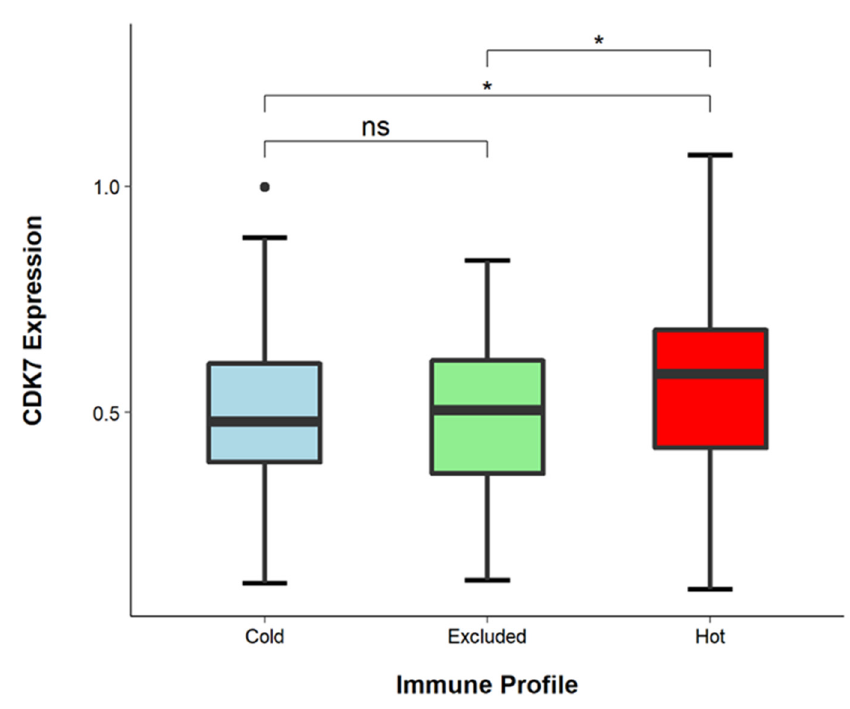
Figure 4. CDK7 expression in different tumor immune profiles. Cold tumors had few to no immune cells; in excluded tumors, immune cells were only present in the tumor stroma; and in hot tumors, immune cells were diffusely infiltrating in between the tumor cells. Compared to cold and excluded tumors, hot tumors harbored a significantly higher CDK7 expression (hot vs. cold p = 0.045, hot vs. excluded p = 0.044), while cold and excluded tumors showed no significant difference ( p = 0.91). * p < 0.05, ● Outliers.